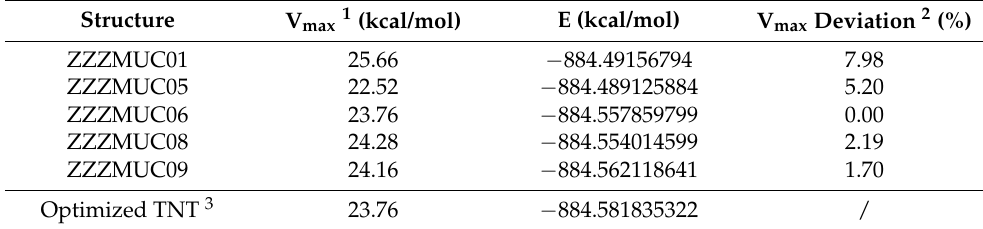
Table 3. Total energies, V max deviations and V max values in critical points above the centers of ni- troaromatic rings calculated for selected crystal structures containing TNT molecule.